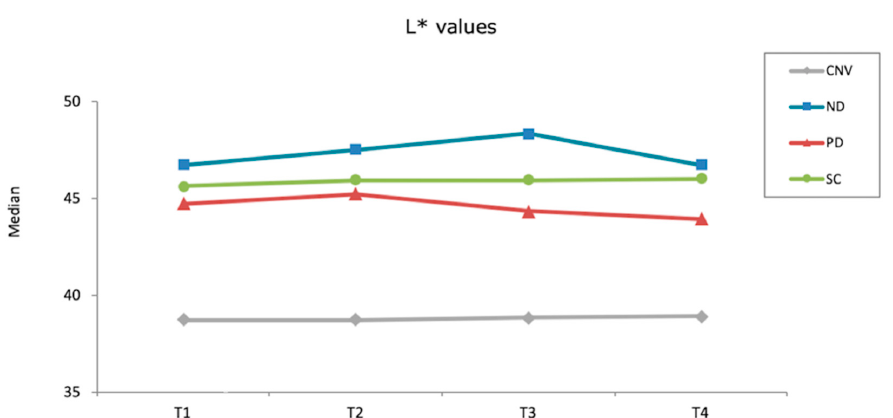
case letters for columns) ( p < 0.05).